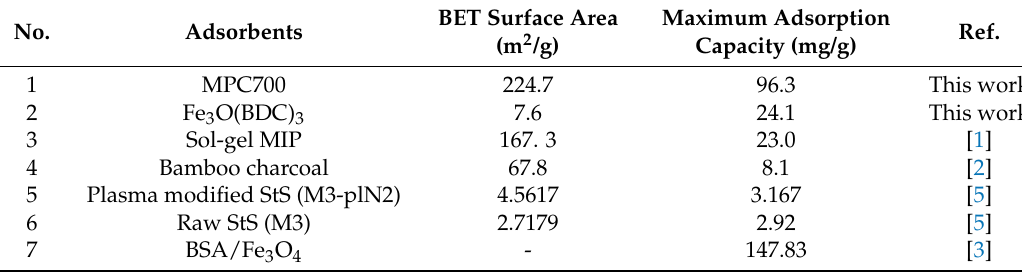
Table 6. A comparison of BET surface area and adsorption capacity of